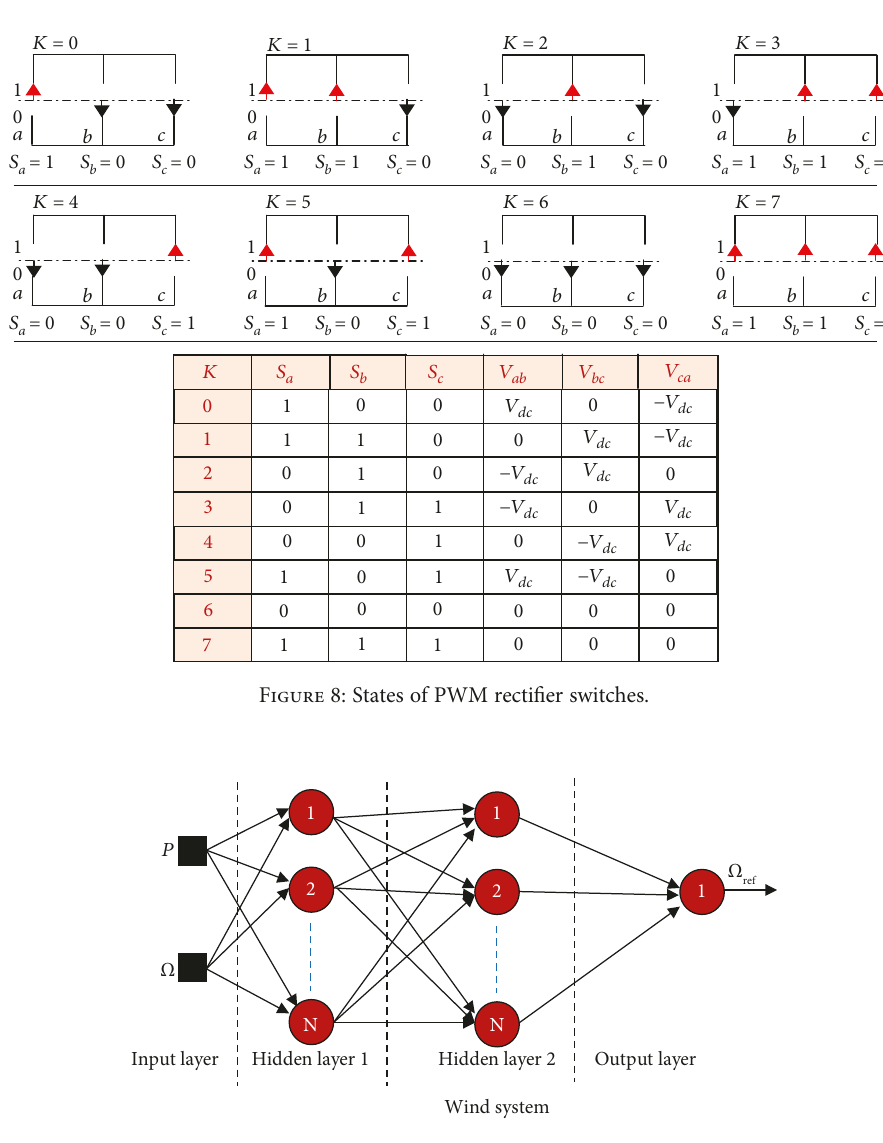
Figure 9: Neural network